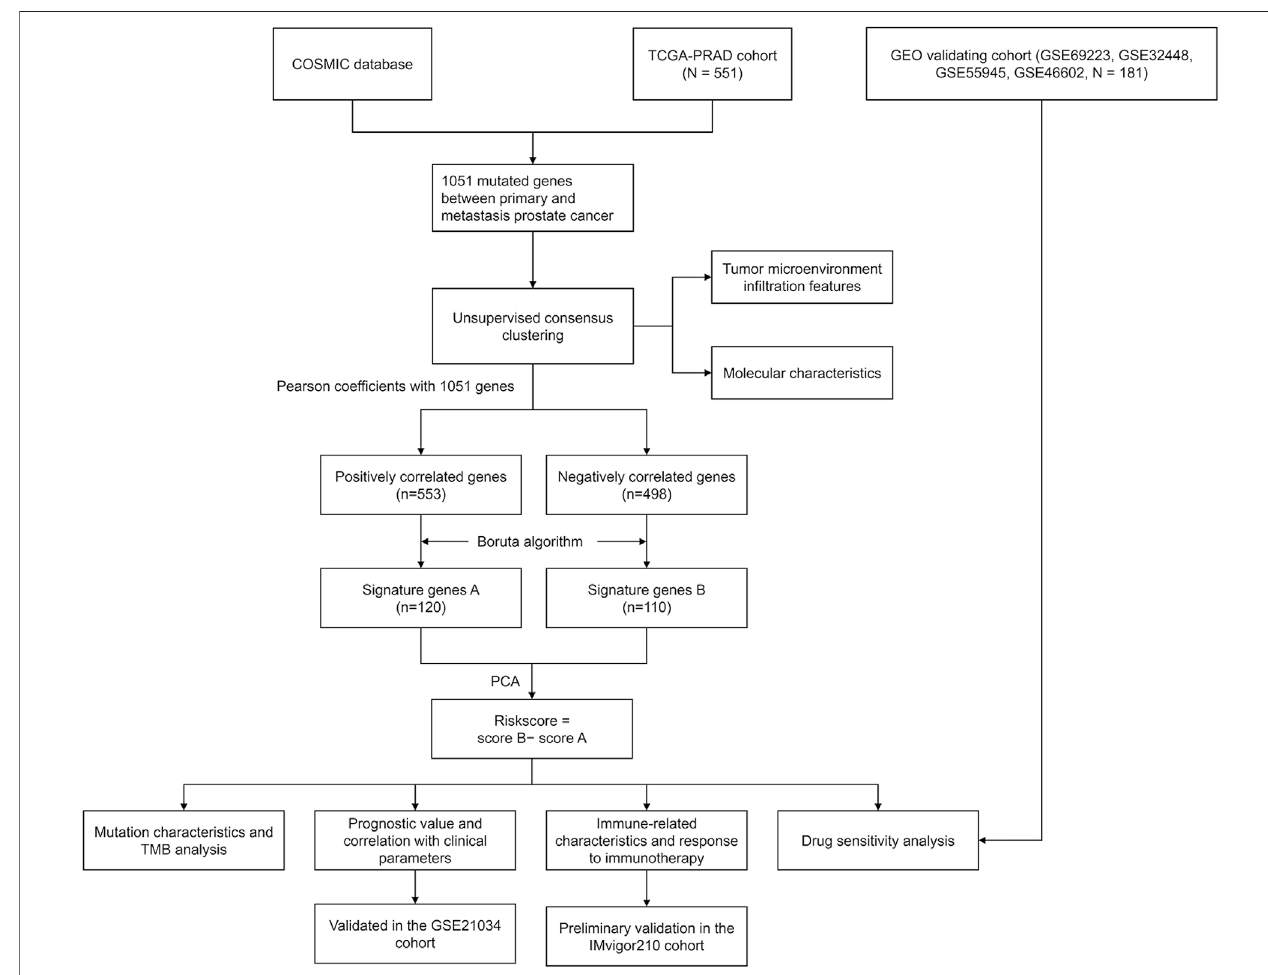
FIGURE 1 | Flow chart of this